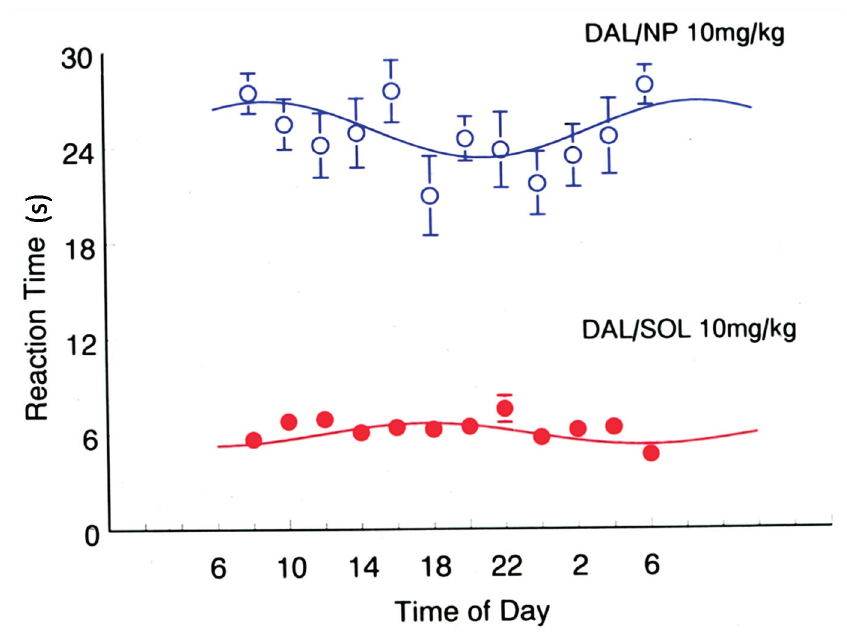
Figure 1. Dependence of the reaction times (s) in the hot-plate test 15 min after intravenous injection of 10 mg/kg of a dalargin solution (DAL/SOL) or of dalargin-coated nanoparticles (DAL/NP) on the time of day. Groups of 10–12 DAB/2 mice were tested every 2 h within 24 h; lights on from 07:00 to 19:00. Shown are mean values ± SEM; the solid line represents the cosine fit to the data. (Adapted with permission from